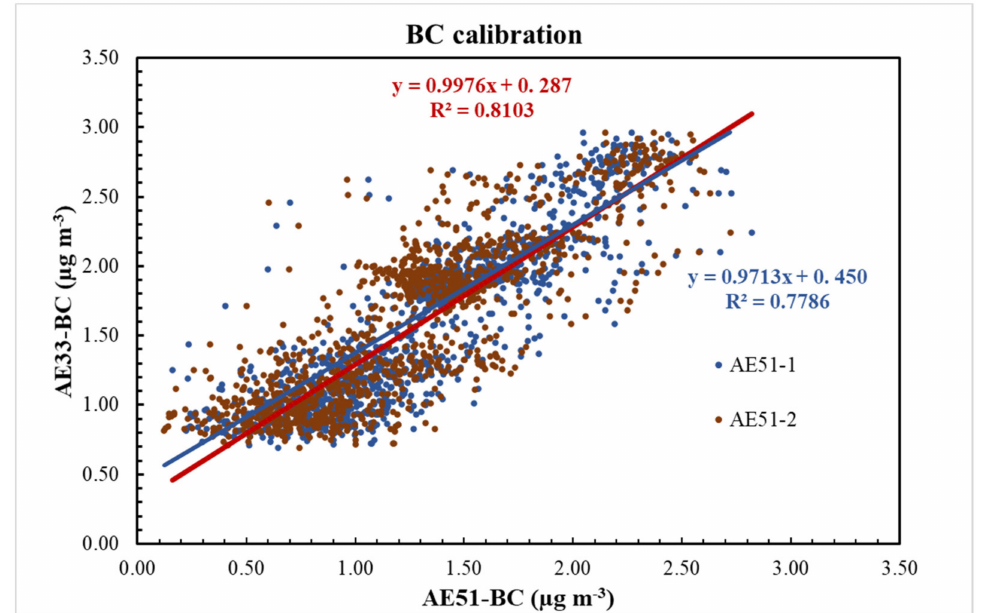
Figure A2. Intercomparison of the microAeth AE51 and the Aethalometer AE33. The solid lines (blue and red) show the linear regression fit to the data.